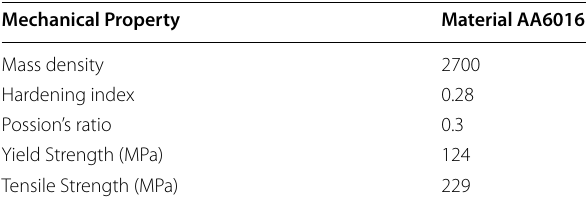
Table 2 Major mechanical property parameters for numerical simulation